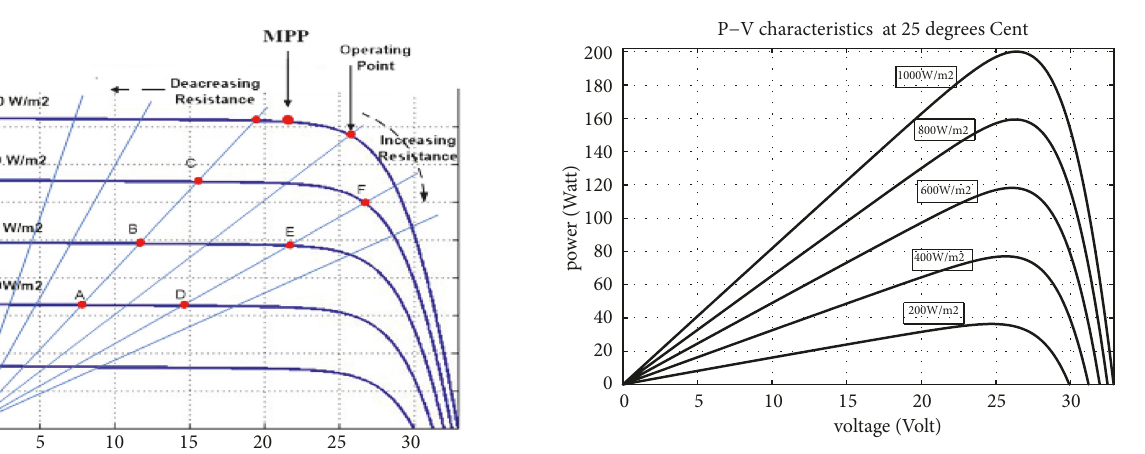
Figure 7: P–V model curves of the KC200GT solar module at different irradiations, 25 ∘ C.